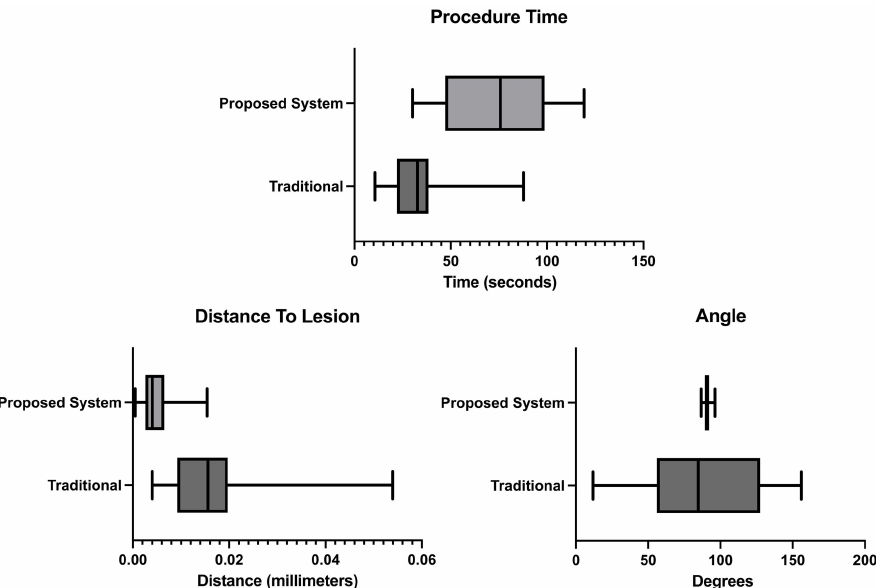
Figure 9. Procedure time, distance from the needle tip to the lesion and angle